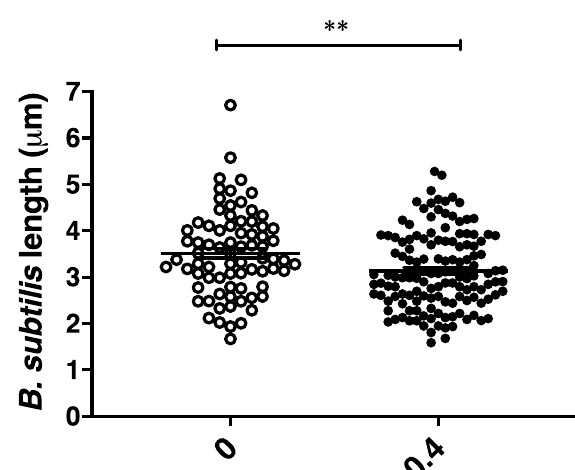
Figure 3. Reduction in B. subtilis length following treatment. B. subtilis cells in exponential phase (OD 600 0.1–0.3) were treated with CBCA at 0.4 × MIC. At 30 min, bacterial cell suspensions were deposited on agarose pads for live phase-contrast microscopy with the Zeiss AxioPlan 2 Upright Light Microscope. Image analysis was performed with AxioVisio (Zeiss). Each symbol represents an individual bacterial cell. Statistical significance determined by one-way ANOVA (** p < 0.01).